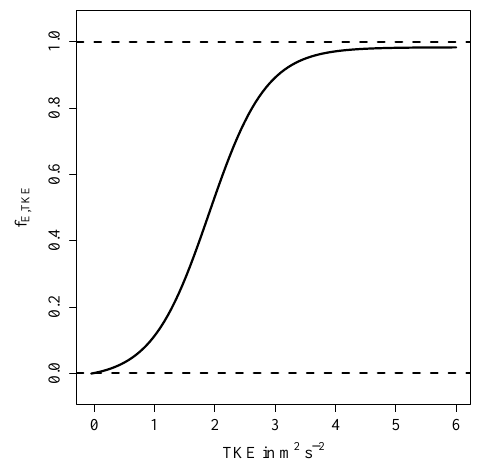
Fig. 3. Function describing the influence of turbulence on the en- trainment of birch pollen grains into the